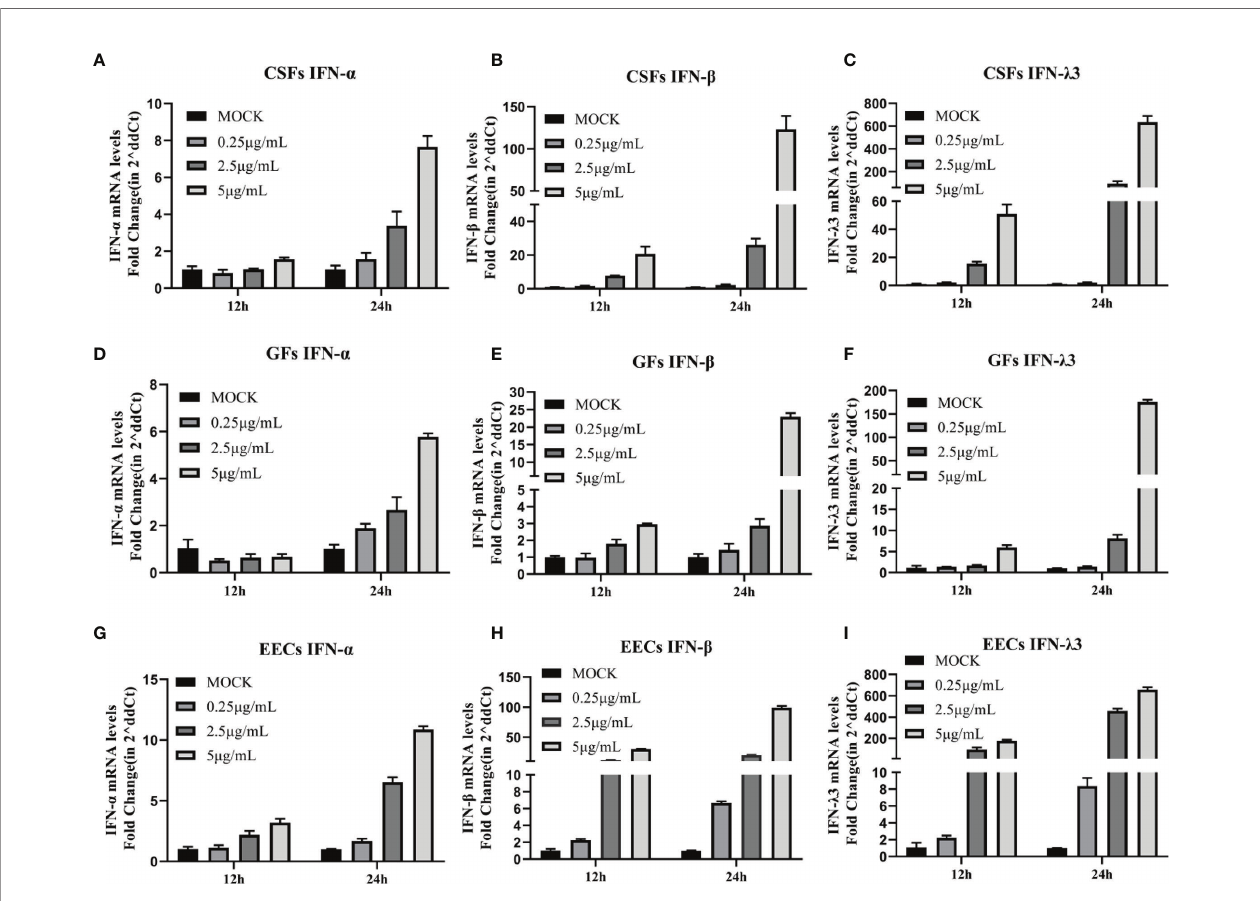
FIGURE 2 | Poly (I: C) induced expression of type I and type III IFNs in epithelial cells and fi broblasts. (A – C) CSFs were stimulated with poly (I: C) for 12 and 24 h, and expression of IFN- a , IFN- b , and IFN- l 3 was measured by RT-PCR. (D – F) GFs were stimulated with poly (I: C) for 12 and 24 h, and IFN- a , IFN- b , and IFN- l 3 expression was measured by RT-PCR. (G – I) EECs were stimulated with poly (I: C) for 12 and 24 h, and expression of IFN- a , IFN- b , and IFN- l 3 was measured by